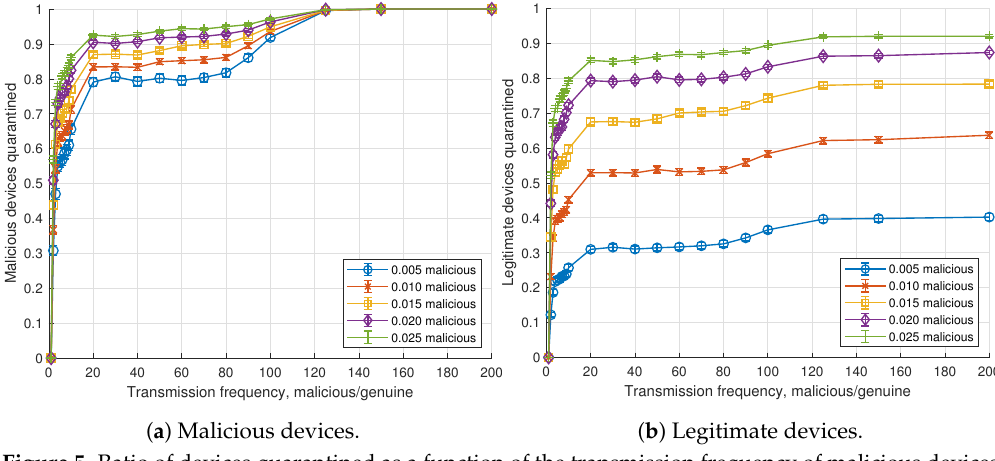
Figure 5. Ratio of devices quarantined as a function of the transmission frequency of malicious devices, f m ( n = 100, s p = 1s, t r = 1.01) for p m ∈ { 0.005,0.010,0.015,0.020,0.025 }